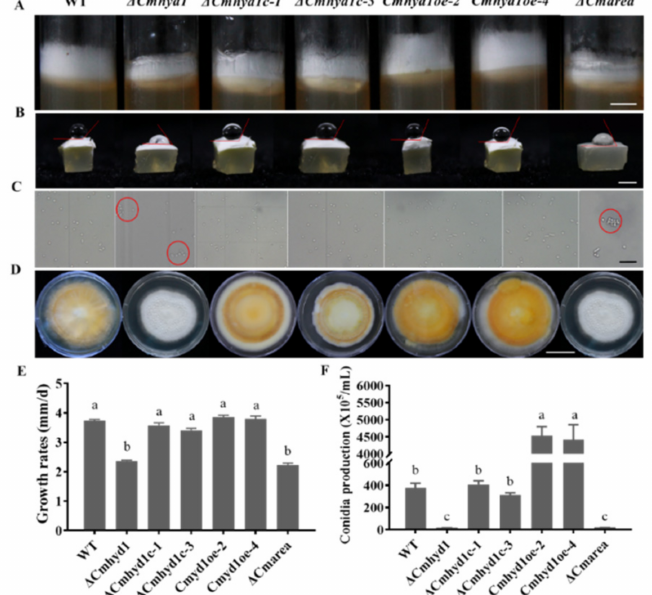
Figure 1. Morphology, growth rate and conidiation in the WT and mutants. ( A ) Aerial mycelia. Aerial mycelia were observed after being cultured for 7 d at 20 ◦ C in a test tube with PDA medium. Bar: 1 cm. ( B ) The hydrophobicity of mycelia. Bar: 1 cm. ( C ) The hydrophobicity of conidia. Bar: 20 µ m. Red circles indicate the conidia which were prone to grouping together. ( D ) Colony morphology, observed after incubation for 21 d at 20 ◦ C on PDA medium and then exposed to 12/12 h white light/dark conditions for 4 d. Bar: 3 cm. ( E ) Growth rates. ( F ) Conidium production. Error bars indicate the standard deviation (SD) of three replicates. Different letters above the bars indicate significant differences (analysis of variance followed by Duncan’s multiple range test, p <